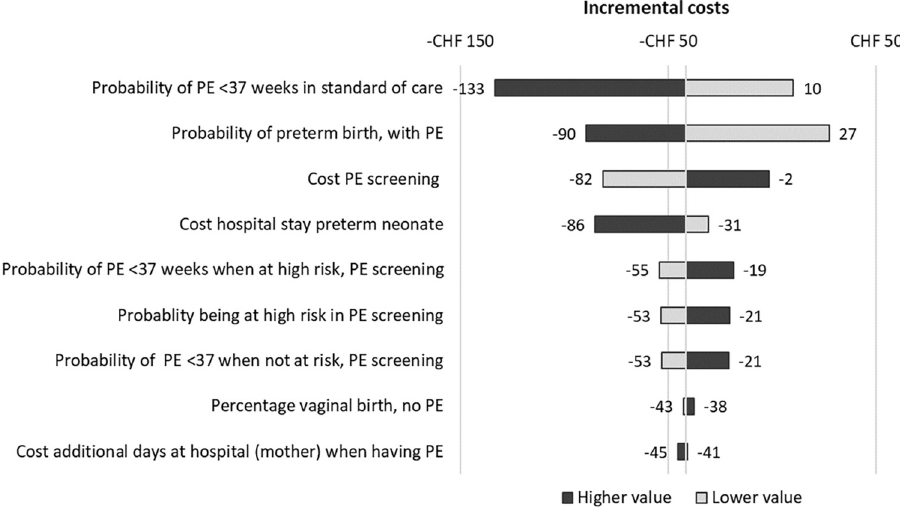
Fig 3. Tornado diagram Switzerland. Base case value is: -CHF 42. PE relates to preterm PE < 37 weeks of gestation.